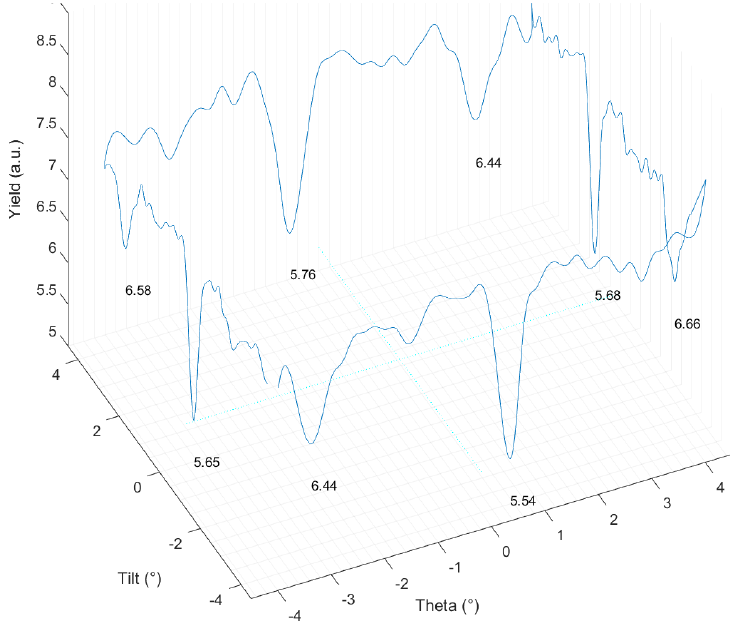
Figure 15. Coarse measurement results.